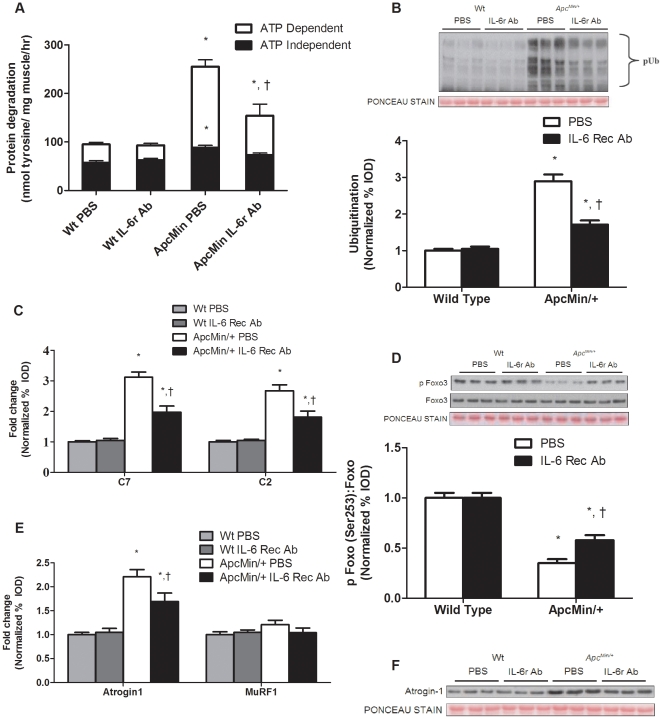
IL-6 inhibition by IL-6 receptor antibody attenuates protein degradation and ubiquitin proteasomal degradation.Wild type and ApcMin/+ mice were given an IL-6 receptor antibody or PBS control at 16 weeks of age and sacrificed at 18 weeks. A) Protein degradation determined by tyrosine release assay. White bars represent ATP dependent degradation; Black bars represent ATP independent degradation. B) Upper representative western blot of ubiquitinated proteins in the gastrocnemius muscle. Lower Quantification of ubiquitinated proteins normalized to wild-type PBS control mice. C) Gene expression of C7 and C2 proteasomal subunits. D) Upper: representative western blot of phosphorylated and total forms of Foxo3. Lower: The ratio of phosphorylated and total Foxo3. E) Gene expression of atrogin1 and MuRF1. F) Representative western blot of atrogin1 protein. Values are means ± SE. Significance was set at p<0.05. *Signifies difference from wild-type control. † Signifies difference within ApcMin/+ mice.